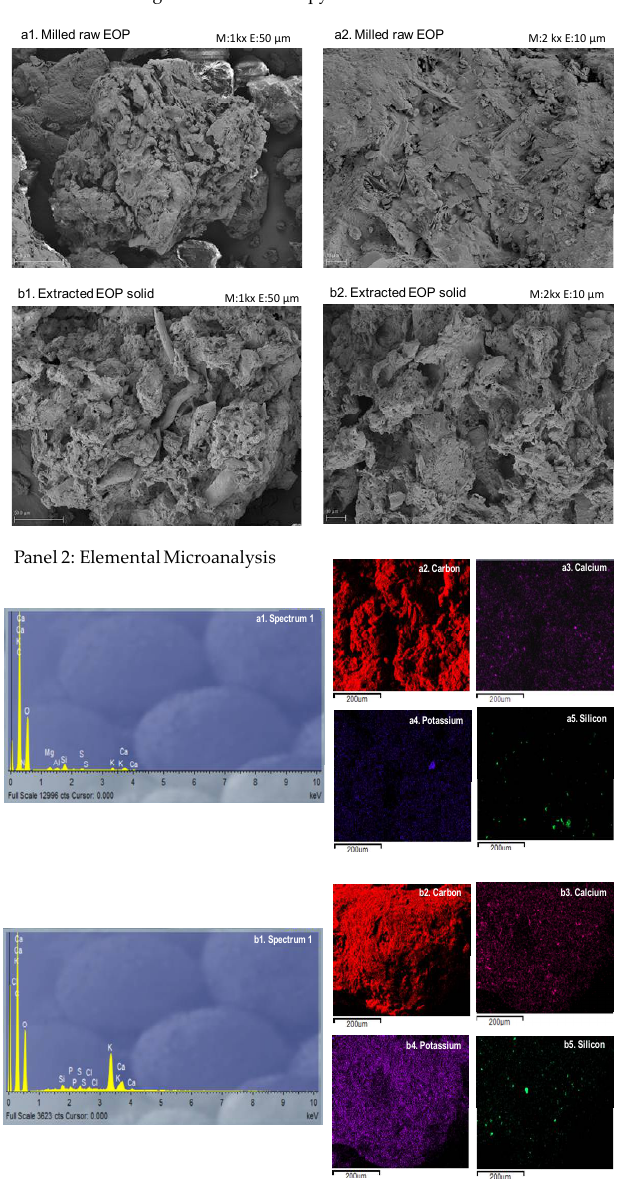
Figure 3. ( Panel 1 ): Scanning electron microscopy images of the milled raw exhausted olive pomace (EOP) ( a1 , a2 ) and the extracted EOP solid obtained after microwave-assisted water extraction under optimized conditions (12% w / v , 100 °C, and 16 min) ( b1 , b2 ). ( Panel 2 ): Spectrum and elemental maps of carbon, calcium, potassium, and silicon of the milled raw exhausted olive pomace (EOP) ( a1–a5 ) and the extracted EOP solid ( b1–b5 ) obtained by microwave-assisted water extraction at optimal conditions (12% w / v , 100 °C, and 16 min). The images were acquired by scanning electron microscopy–energy dispersive X-ray spectrometry.